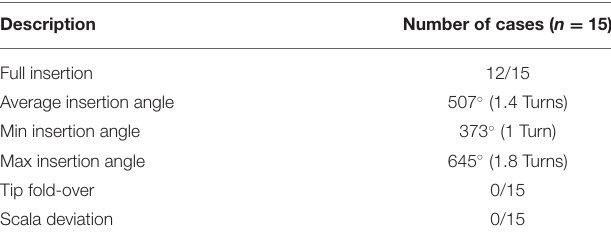
TABLE 1 | Insertion status analysis from post-operative images. TABLE 2 | Detailed insertion status analysis from post-operative